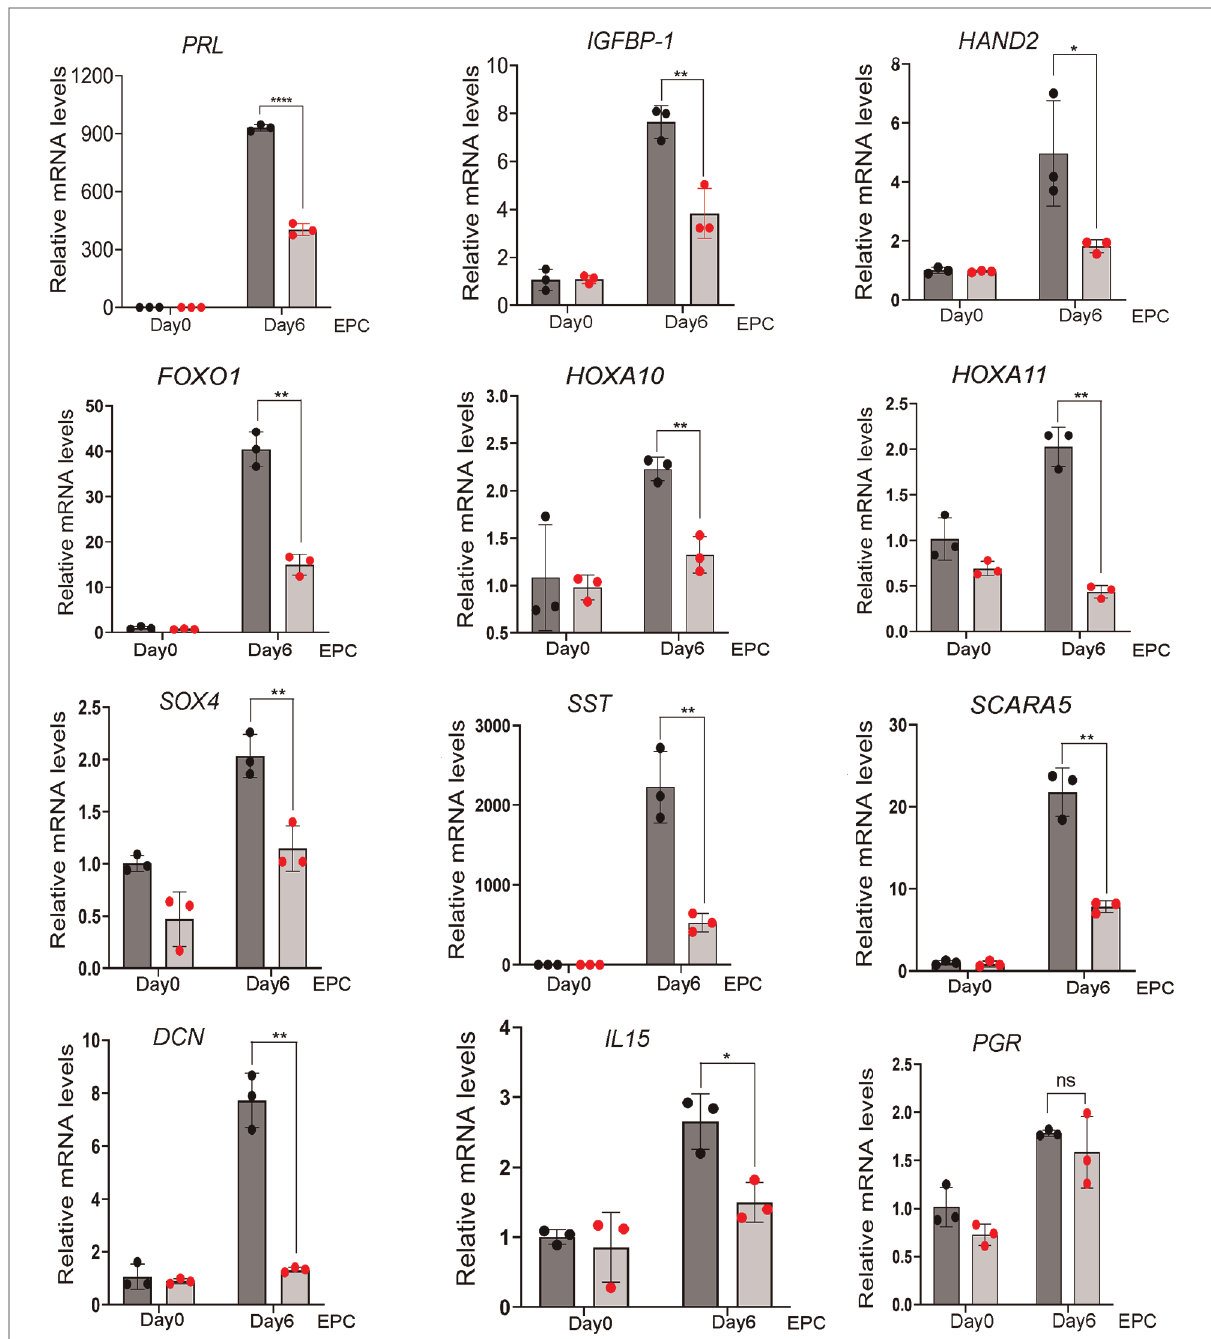
FIGURE 4 Depletion of SRC-3 in T-HESCs results in a signi fi cant attenuation in the induction of established decidual cell markers following EPC culture. Quantitative real-time PCR reveals that siRNA mediated SRC3 knockdown resulted in a marked reduction in the induction of the